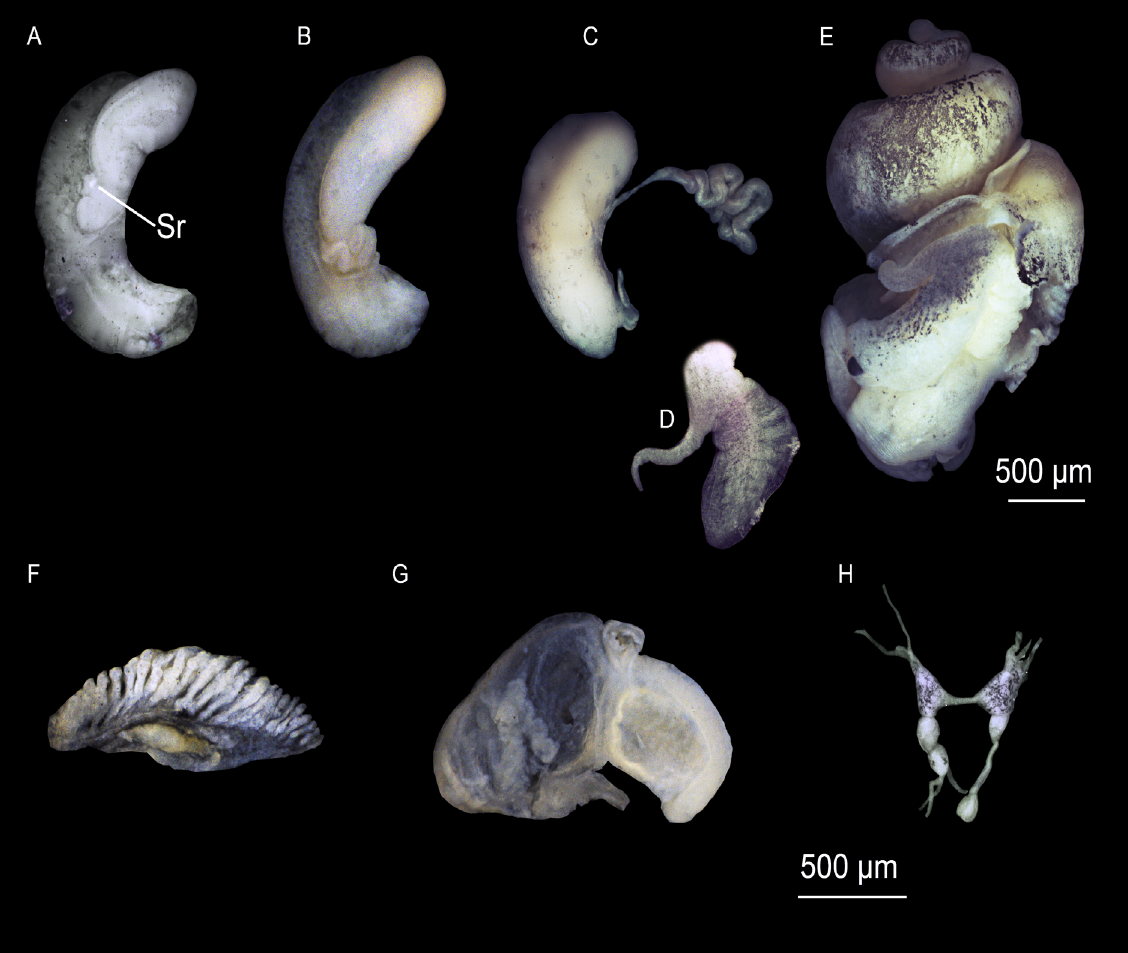
Fig. 25. Anatomy of Mercuria felixi Miller, García-Guerrero & Ramos sp. nov. from the stream in Canuto de la Tala, Cádiz, Spain. A – B . Female genitalia. C . Prostate gland. D . Penis. E . Animal and penis. F . Ctenidium and osphradium. G . Stomach. H . Perioesophageal